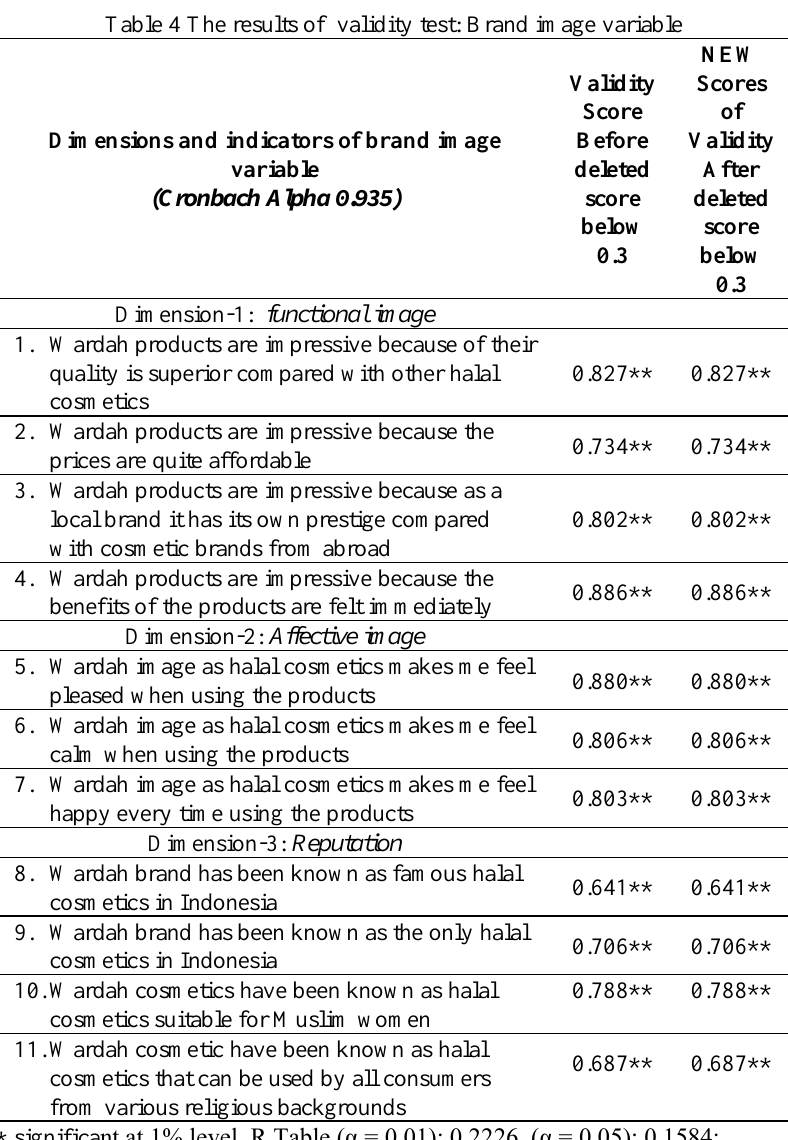
Table 4 The results of validity test: Brand image variable